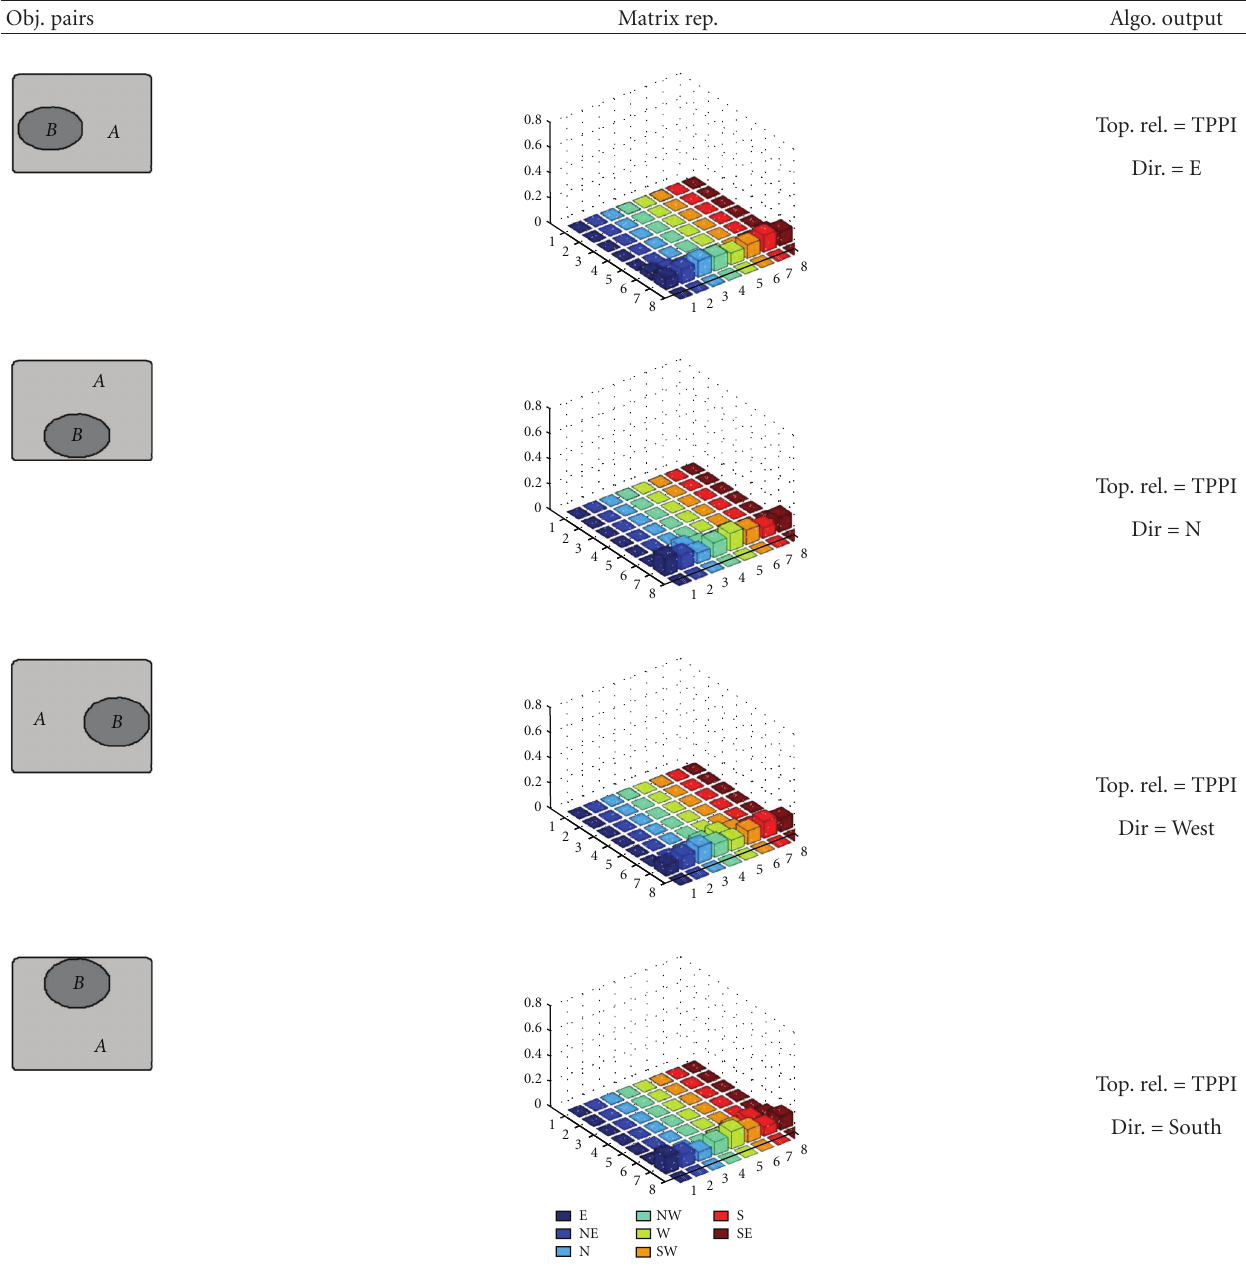
Table 6: Object pairs with TPPI topological and their directional relations. Obj. pairs Matrix rep. Algo. output